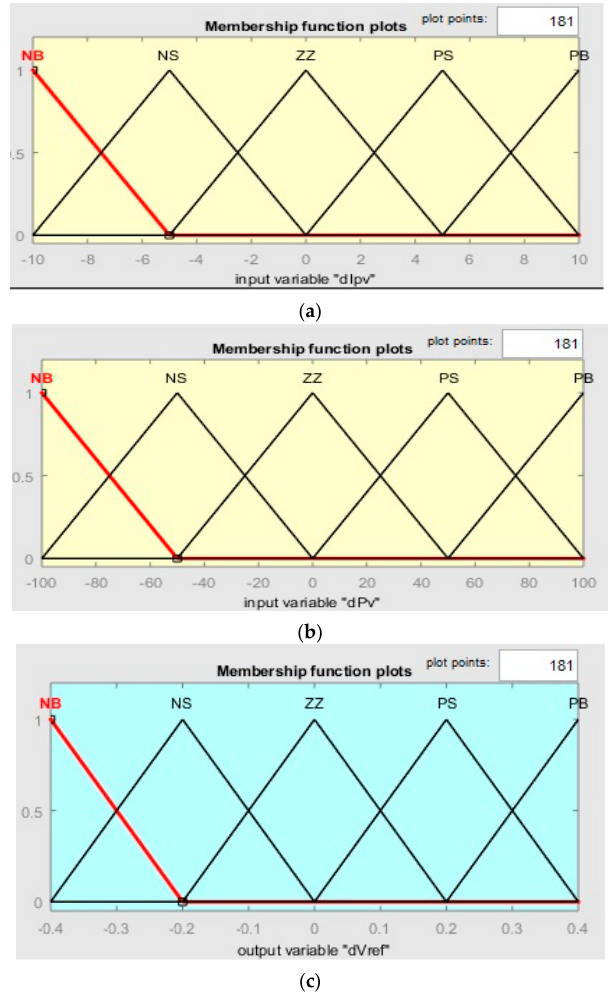
Figure 5. ( a , b ) Membership functions of the input variables ( ∆ P PV , ∆ I PV ) and ( c ) the output variable ∆ V ref